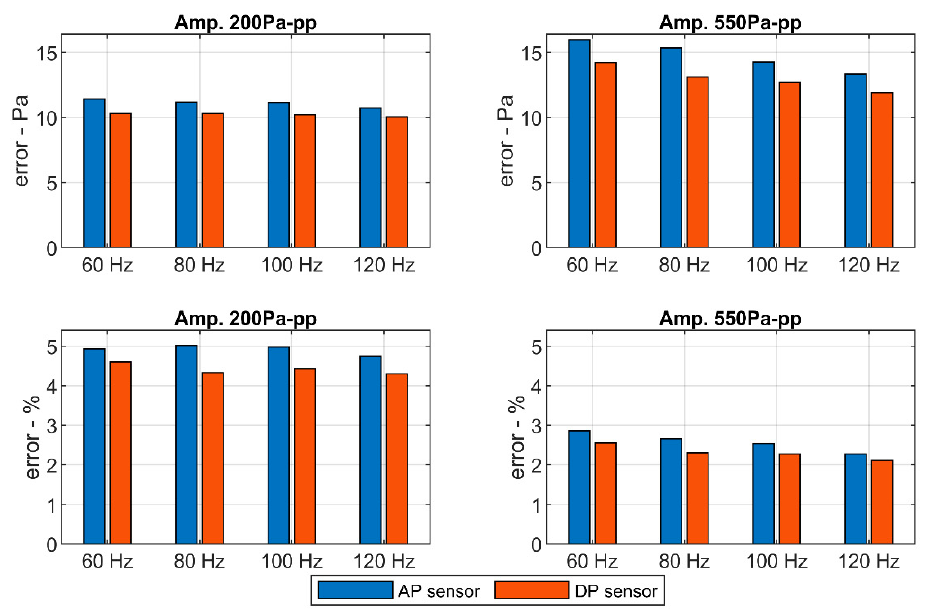
Figure 7. Error computed for the signals of the low-cost sensors with respect to the high-fidelity microphone.